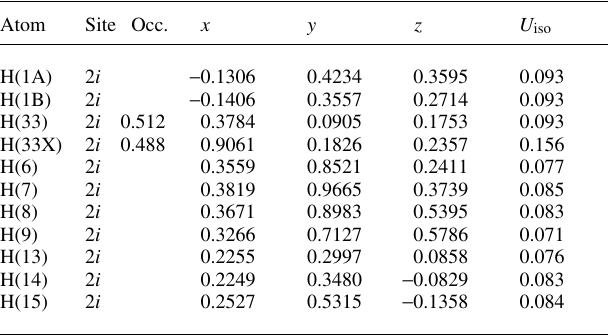
Table 2. Atomic coordinates and displacement parameters (in Å 2 )